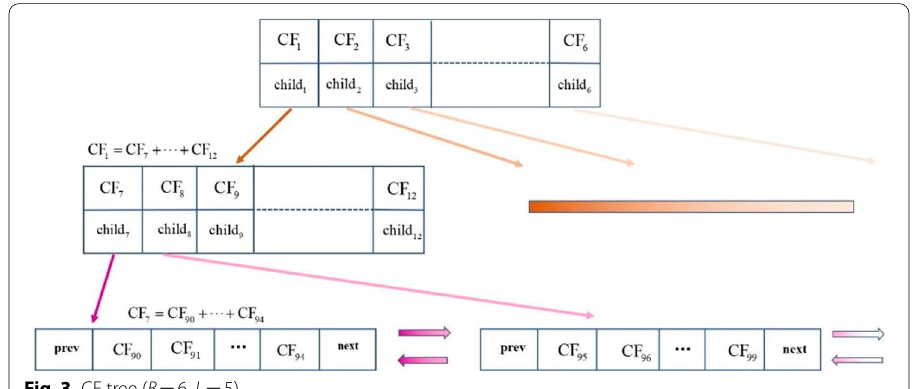
Fig. 3 CF tree ( B